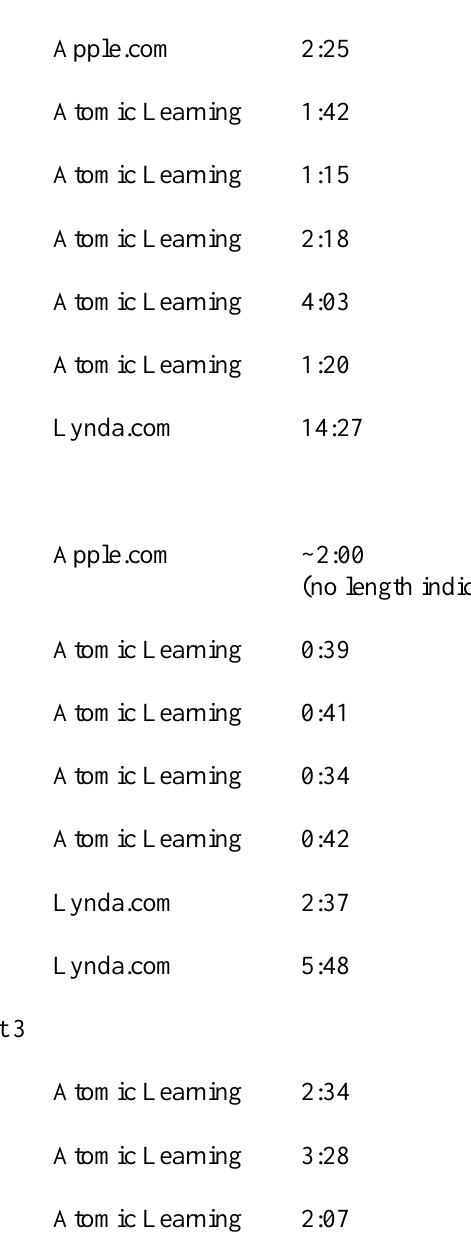
Table 3 Professionally Produced Screencasts Screencast topic/title Podcasting using GarageBand Creating a Podcast Setting up the Metronome Using the Count in Feature Punching in a Fake Recording Multi-Take Performances Recording with Multiple Tracks